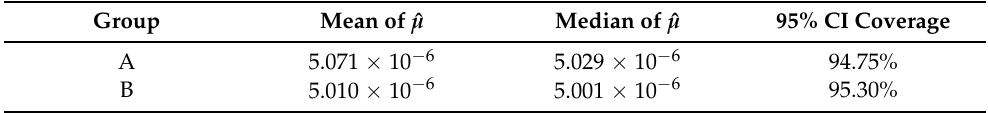
Table 6. Summary of algorithm